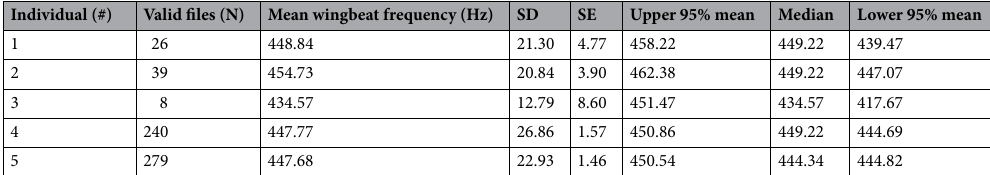
Table 2. Observed Individual wingbeat frequencies of Culex